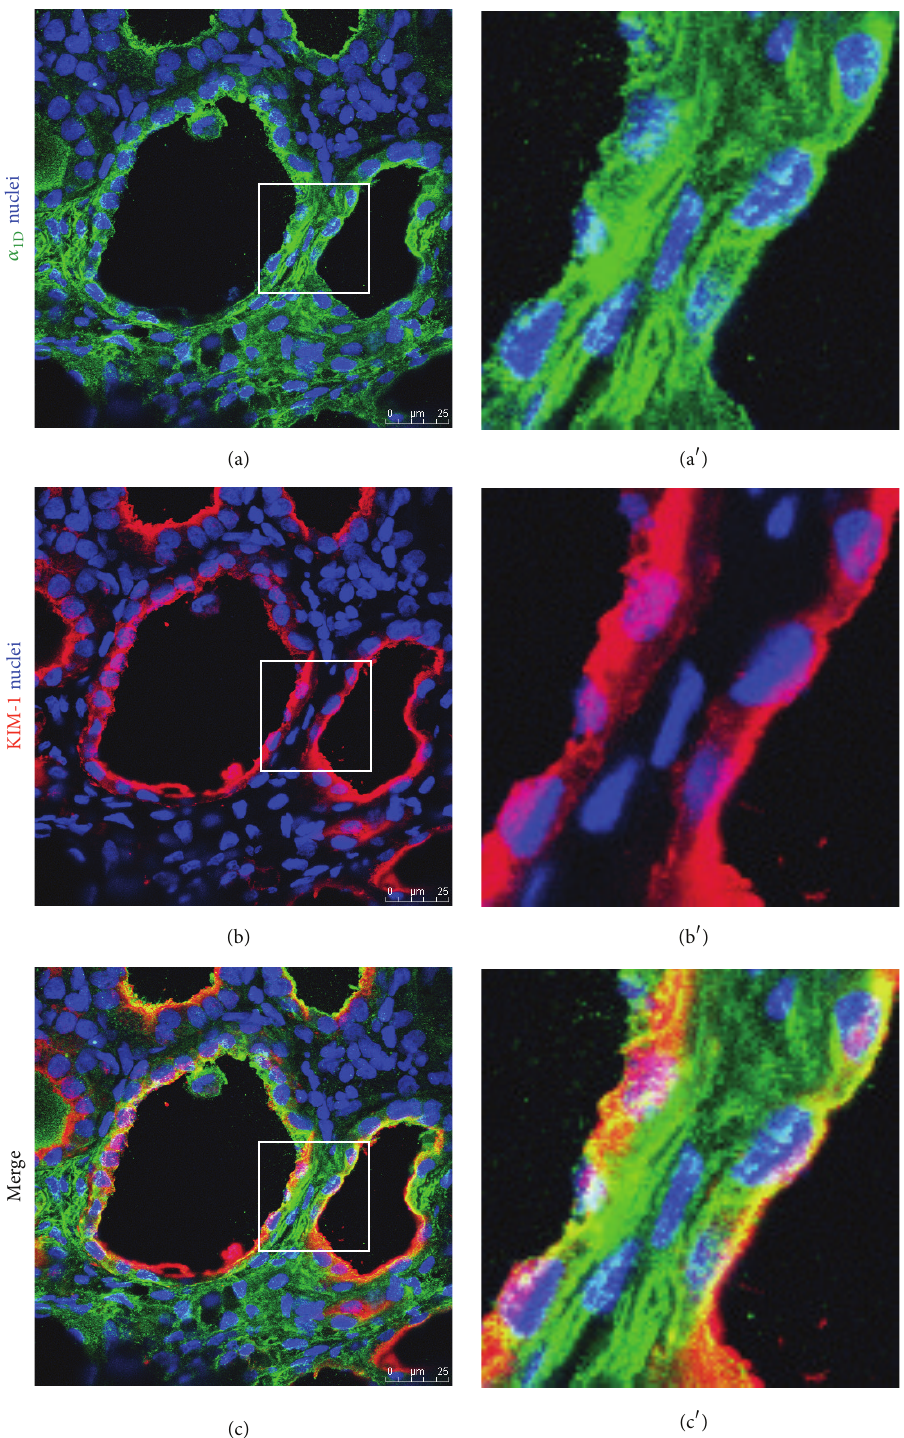
Figure 6: Representative confocal images of double staining for 𝛼 1 -AR (green) and Kim-1 (red) was seen in the dilated proximal tubules of diabetic rats. Images in (a 󸀠 ), (b 󸀠 ), and (c 󸀠 ) Colocalization of 𝛼 1 D are enlarged from the boxed areas in (a), (b), and